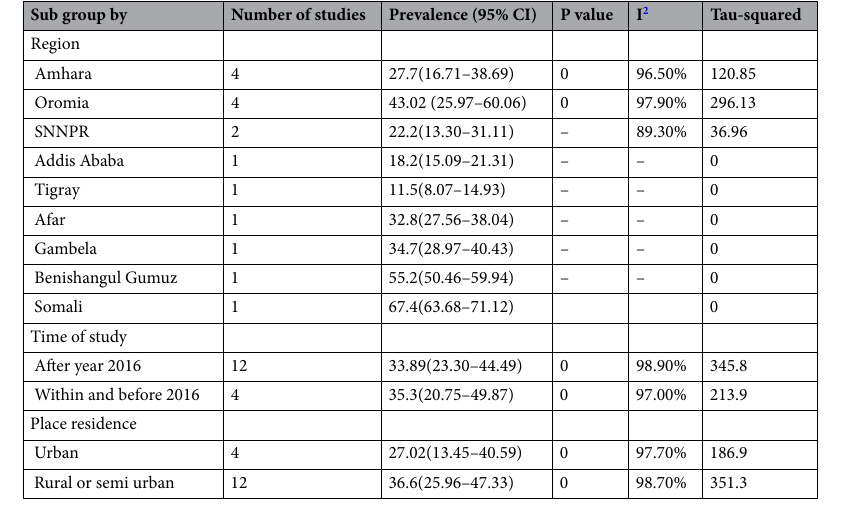
Table 4. Sub-group analysis of food taboo practice among pregnant women in Ethiopia.